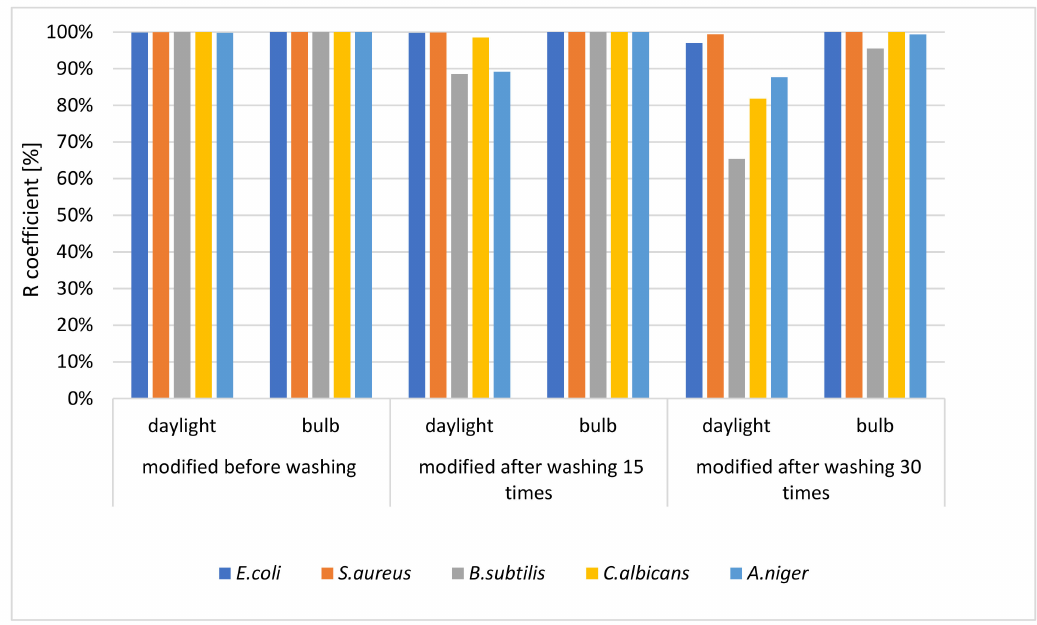
Figure 5. Microorganisms reduction coefficient (R) on tested modified cotton samples/before and after washing (15/30 cycles) incubated in different lighting conditions.